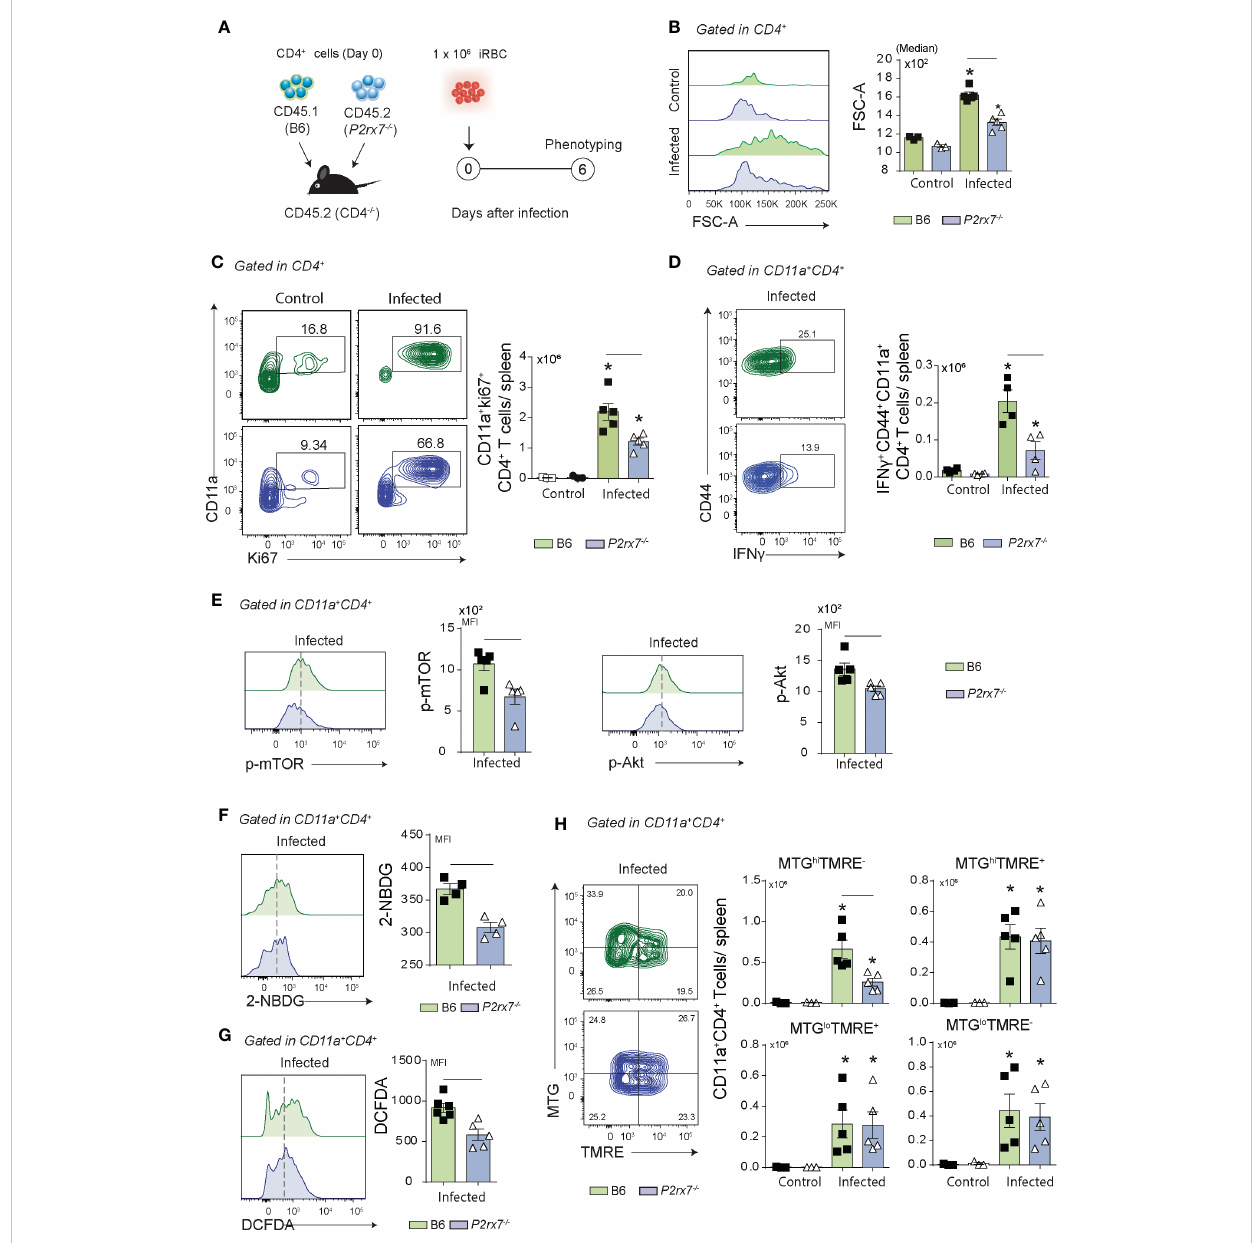
FIGURE 3 Phenotypical analysis of metabolic markers in co-transferred B6 and P2rx7 -/- CD4 + T cells at early Plasmodium infection. Splenic naïve CD4 + T cells from B6 (CD45.1 + ) and P2rx7 -/- (CD45.2 + ) mice were co-transferred into Cd4 -/- mice that were infected with 1 × 10 6 iRBCs. Splenic CD45.1 + and CD45.2 + CD4 + T cells were analyzed at day 6 of infection. Non-infected mice were used as controls. (A) A schematic illustration of the experimental protocol is shown. (B) Histogram shows forward side scatter area (FSC-A) of CD4 + T cells and the medians are shown in the column bar graph. (C) Contour plots show CD11a versus Ki67 expression in CD4 + T cells. Column bar graph shows CD11a + Ki67 + CD4 + T cell numbers per spleen. (D) Contour plots show CD44 versus intracellular IFN g expression in CD11a + CD4 + T cells. Column bar graph shows IFN g + CD44 + CD11a + CD4 + T cell numbers per spleen. (E) Histograms show p-mTOR or p-Akt expression in CD4 + T cells. Column bar graphs show mTOR and Akt MFIs. (F) Histogram shows 2-NBDG staining in CD11 + CD4 + T cells. Column bar graph shows 2-NBDG MFIs. (G) Histogram shows DCFDA (2 ′ ,7 ′ -dichloro fl uorescin) staining in CD11 + CD4 + T cells. Column bar graph shows DCFDA MFIs. (H) Contour plots show MTG versus TMRE staining in CD11a + CD4 + T cells. Column bar graphs show MTG hi TMRE + , MTG hi TMRE - , MTG lo TMRE + and MTG lo TMRE - CD11a + CD4 + T cell numbers per spleen. Data are shown as the mean ± SD (n = 4-5) of one representative experiment out of three. Signi fi cant differences were observed for the (-) indicated groups and (*) between infected and control mice with p < 0.05, using Mann Whitney U